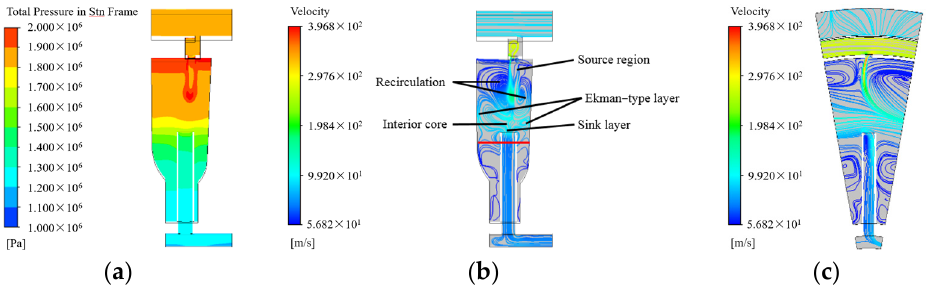
Figure 4. Flow characteristics of the vortex reducer in the disk cavity: ( a ) Total pressure on the meridian plane; ( b ) Streamline on the meridian plane; ( c ) Streamline on the axial section.